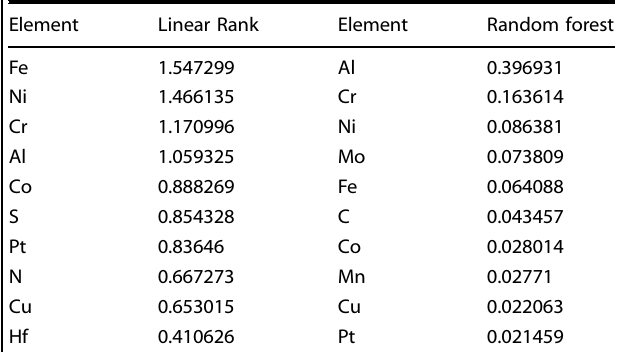
Table 2. The ten most signi fi cant elements according to rank for linear and random